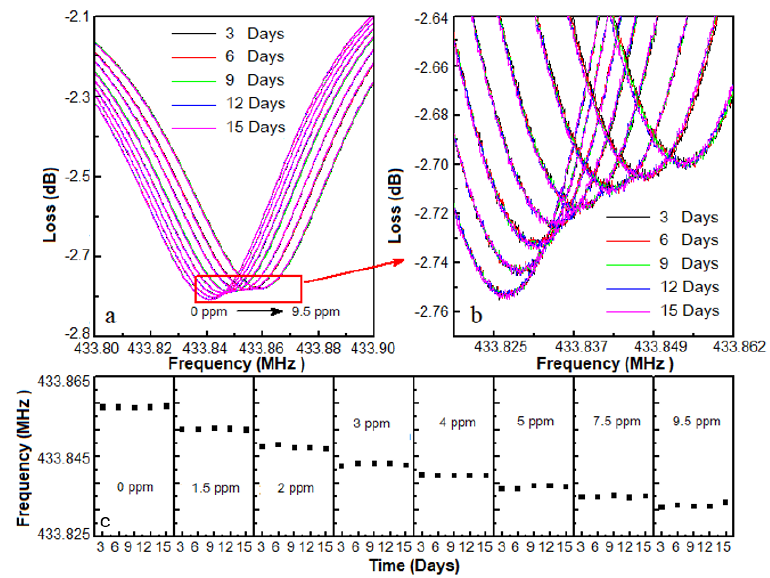
Figure 11. ( a ) Stability of the proposed SAW sensor; ( b ) frequency response curves of the sensor for various DMMP concentrations; ( c ) stability of the sensor stored at ambient conditions.